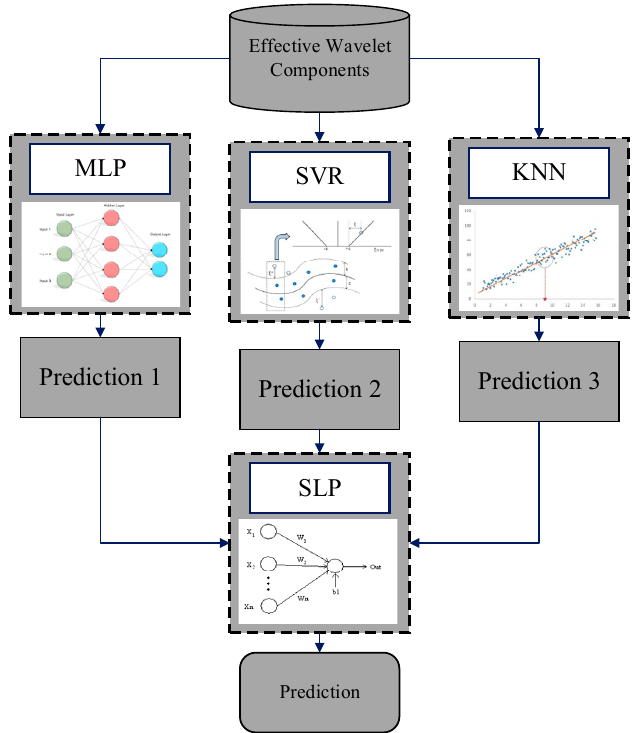
Figure 2. Schematic of the proposed stacking models.